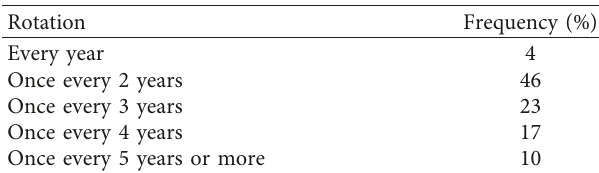
Table 2: Field rotations with herbicide-resistant (glufosinate, glyphosate, and imidazolinone) canola ( Brassica napus L.) in Western Canada: 2012–2014 ( n � 220